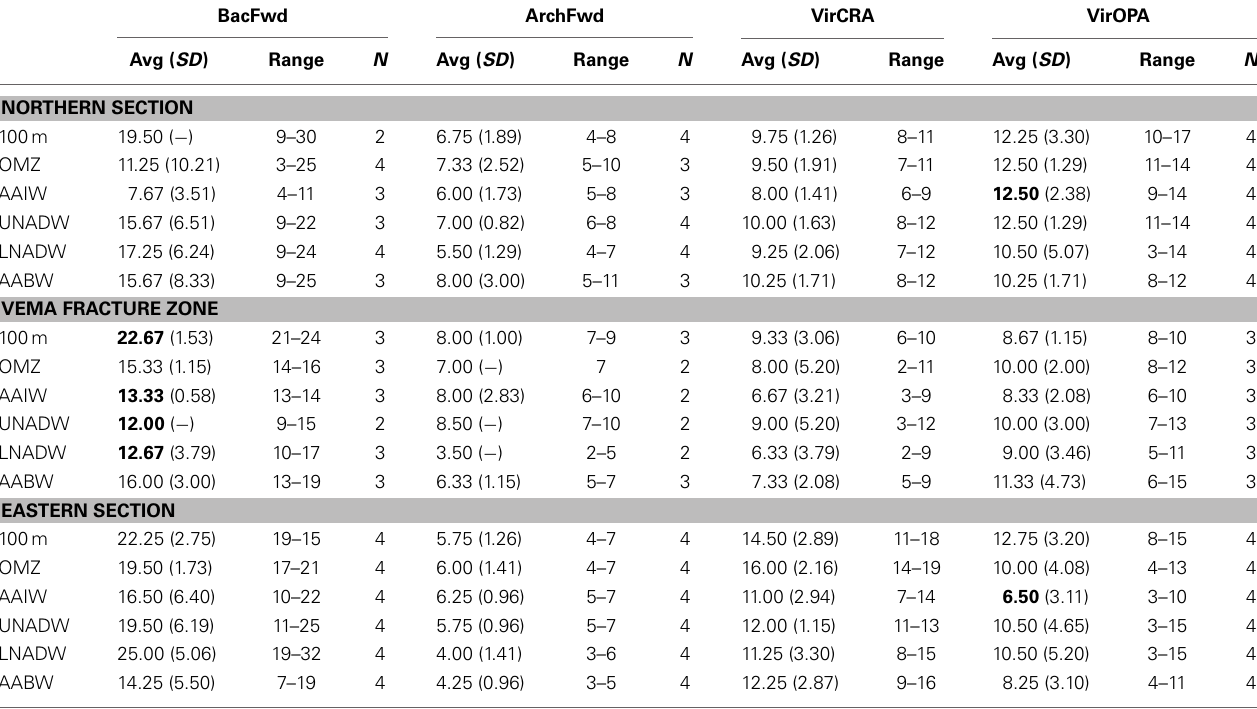
Table 3 | Number of OTUs of T-RFLP (forward primer) and RAPD-PCR data detected within the different water masses north, within and east of the Vema Fracture Zone in the (sub)tropical North Atlantic